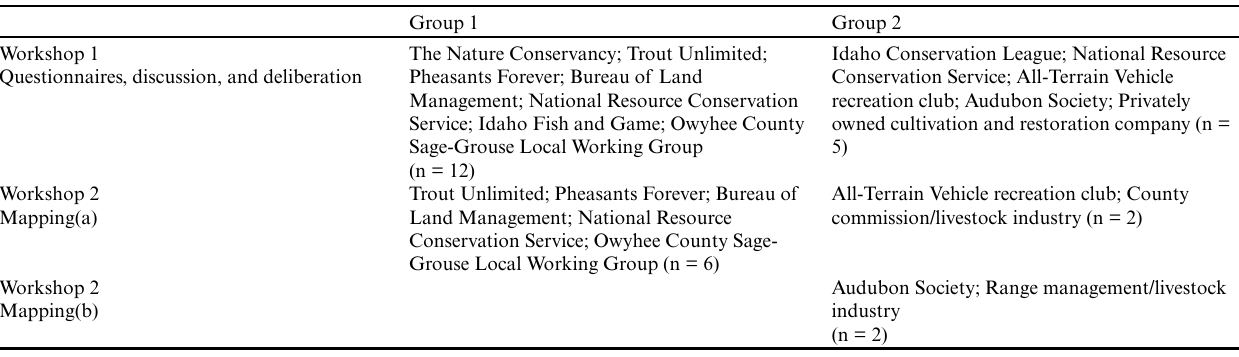
Table 2 . Organizations represented by workshop participants compared across workshop groups and activities.